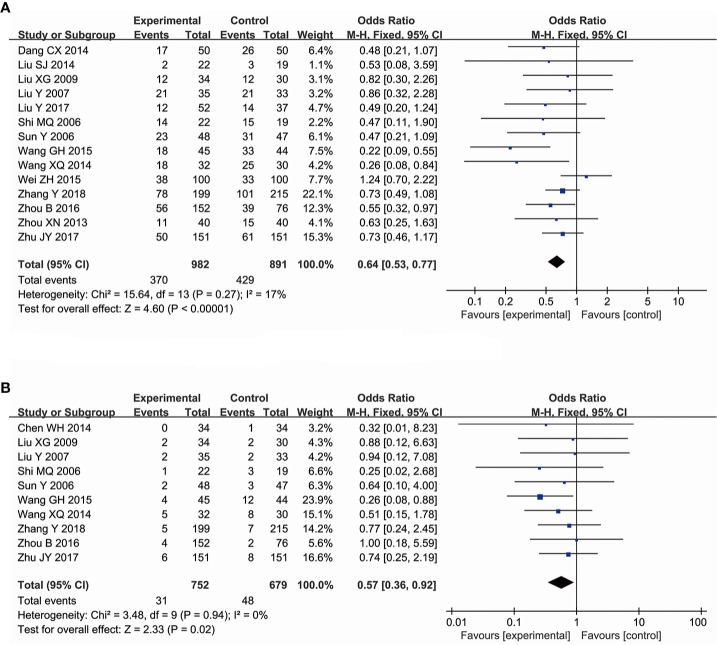
Forest plot for the decline of hemoglobin counts. (A) The decline of hemoglobin counts I–IV. (B) The decline of hemoglobin counts III-IV.